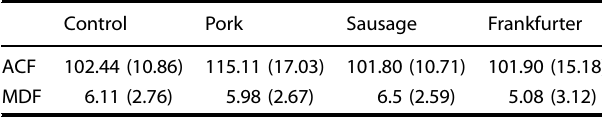
Table 1. Numbers of aberrant crypt foci and mucin depleted foci did not signi fi cantly differ between any